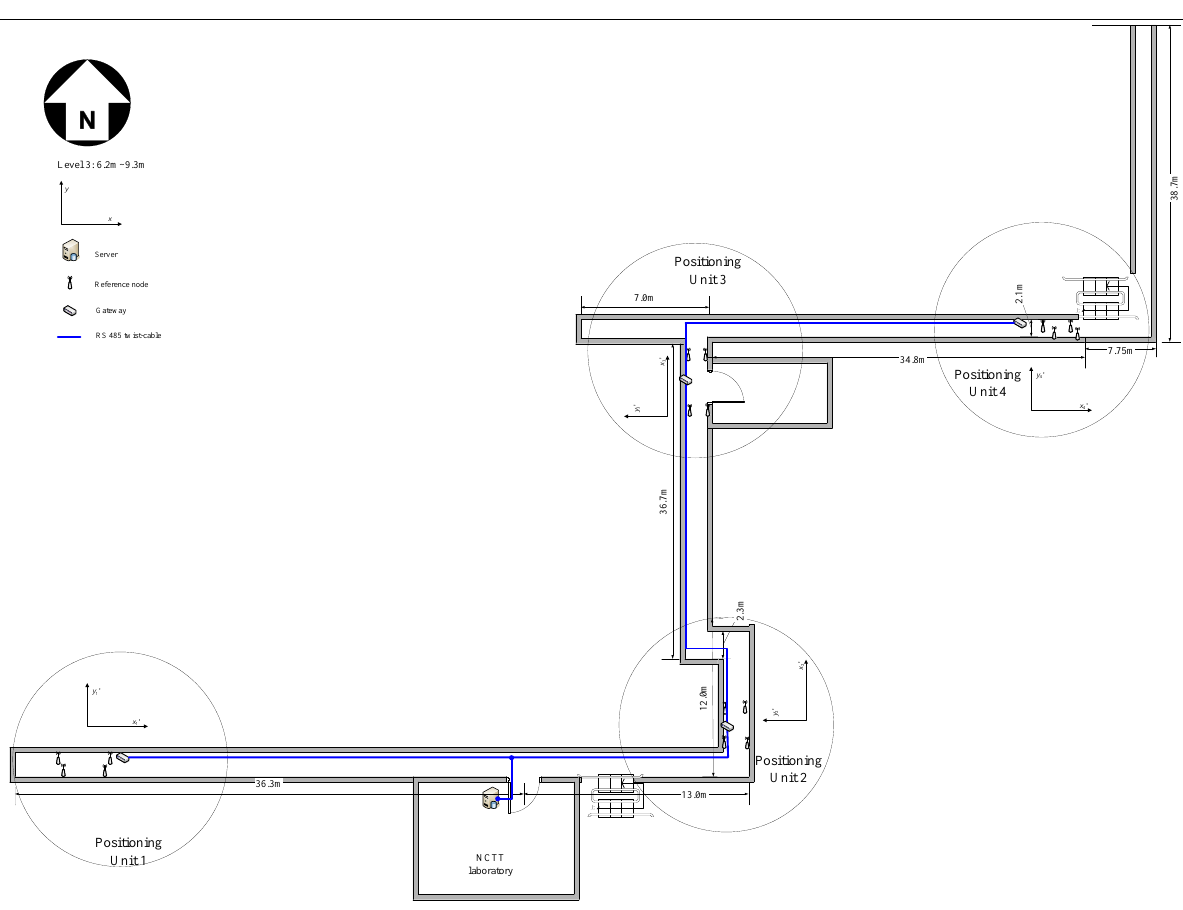
Figure 14. The deployment of positioning system in a corridor.